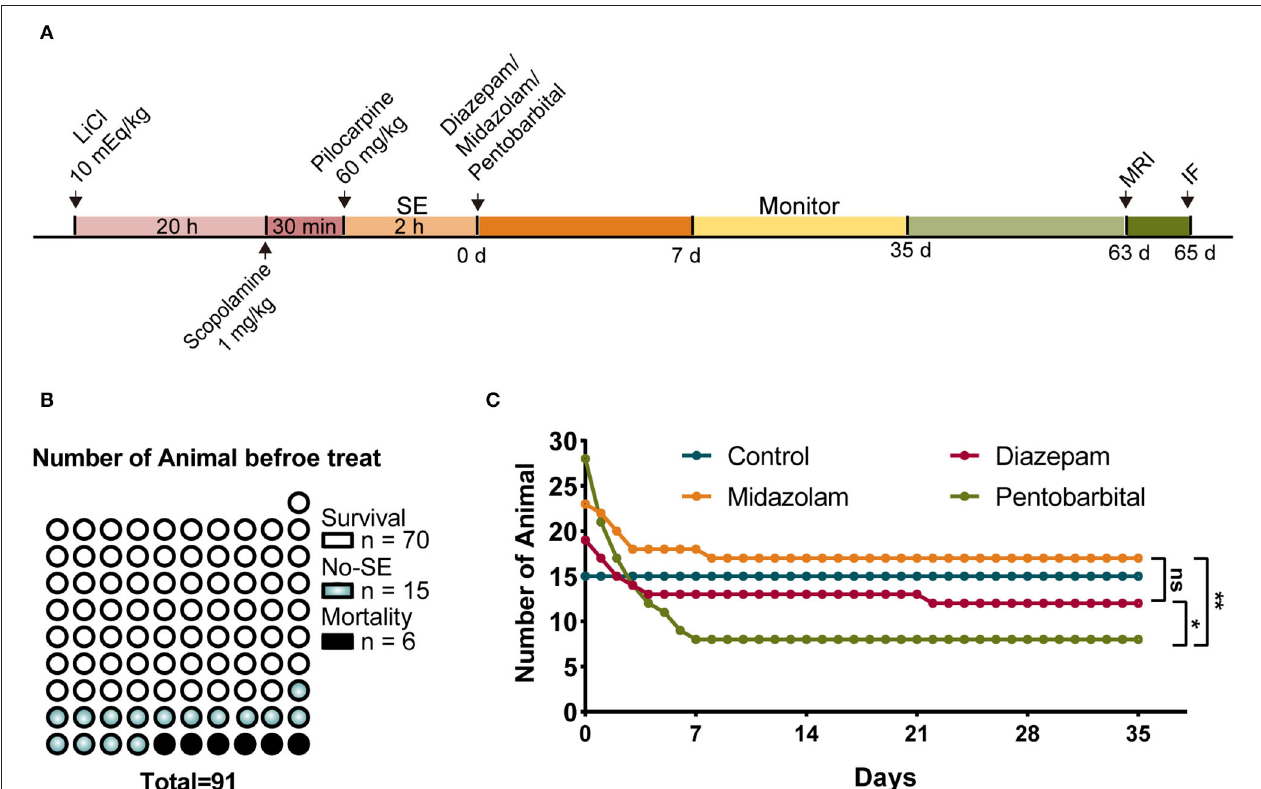
FIGURE 1 | Comparison of mortality after status epilepticus (SE) treated with diazepam, midazolam, and pentobarbital. (A) Experimental paradigm of SE induction by LiCl-pilocarpine and a set of experiments performed after SE induction. ( B) A number of mice of survival from SE, no SE responses (non-SE), and mortality after pilocarpine administration and before anti-SE treatments. (C) Number of mice allocated to the treatments with diazepam, midazolam, and pentobarbital to terminate SE and remaining within 5 weeks after SE. Control mice were no SE and received no treatment. The number of mice at the end of the fifth week/immediately after treatments: control group, n = 15/15; diazepam group, n = 12/19; midazolam group, n = 17/23; pentobarbital group, n = 8/28. Pentobarbital vs. diazepam, p = 0.0343; pentobarbital vs. midazolam, p = 0.0019; diazepam vs. midazolam, p = 0.5159; Fisher’s exact test. * p < 0.05, ** p < 0.01, ns indicates no significant